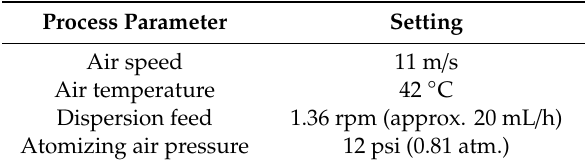
Table 6. The process parameters used in the manufacturing of the meloxicam pellets coated with Eudragit ® .